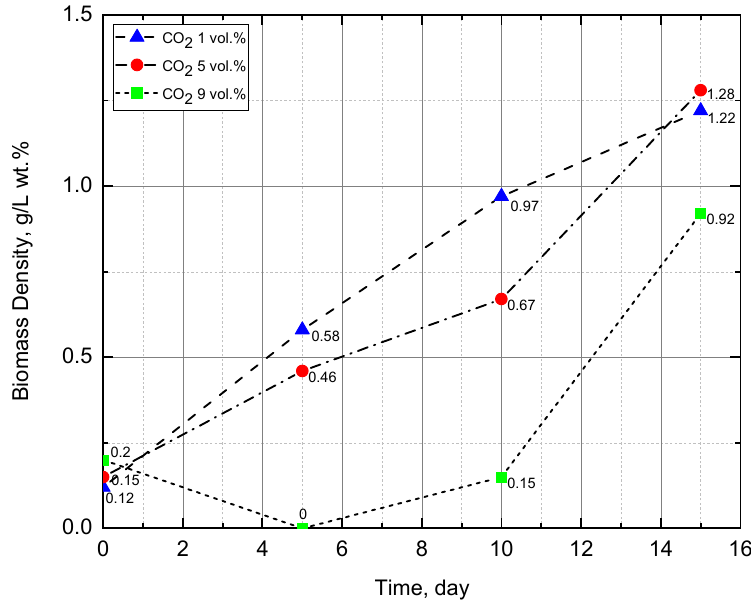
Figure 5. Change of biomass density during the experiments.